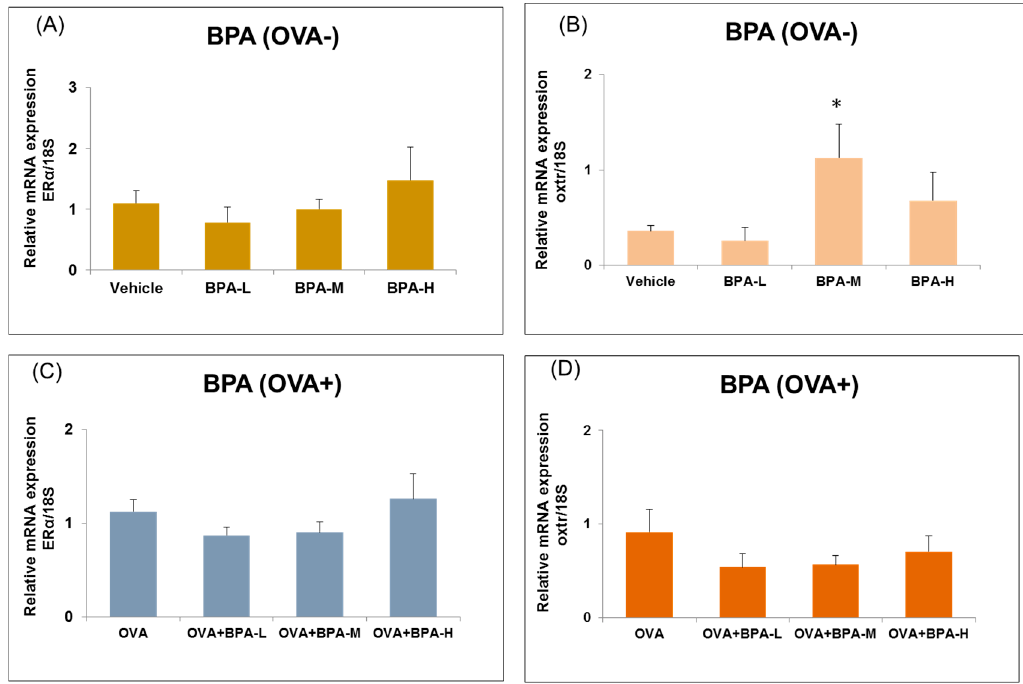
Figure 7. Expression level of estrogen receptor (ER α ) and oxytocin receptor (oxtr) in the hypothalamus of male mice exposed to BPA without OVA ( A and B ) and with OVA ( C and D ). Each bar represents the mean + SE ( n = 5~6, * p < 0.05 versus vehicle).